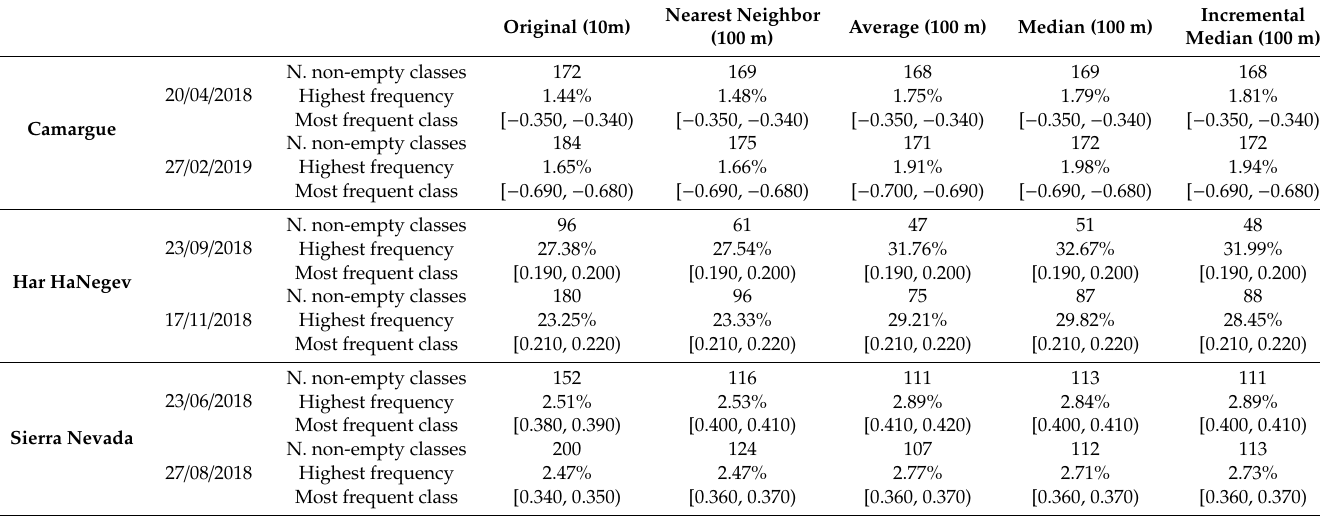
Table 9. Density function characteristics for two scenes per protected area at the original (10 m) and 100 m resolution using several resampling methods. The maximum number of classes in the density function is 200 (class width of 0.01, values from − 1.00 to 1.00).